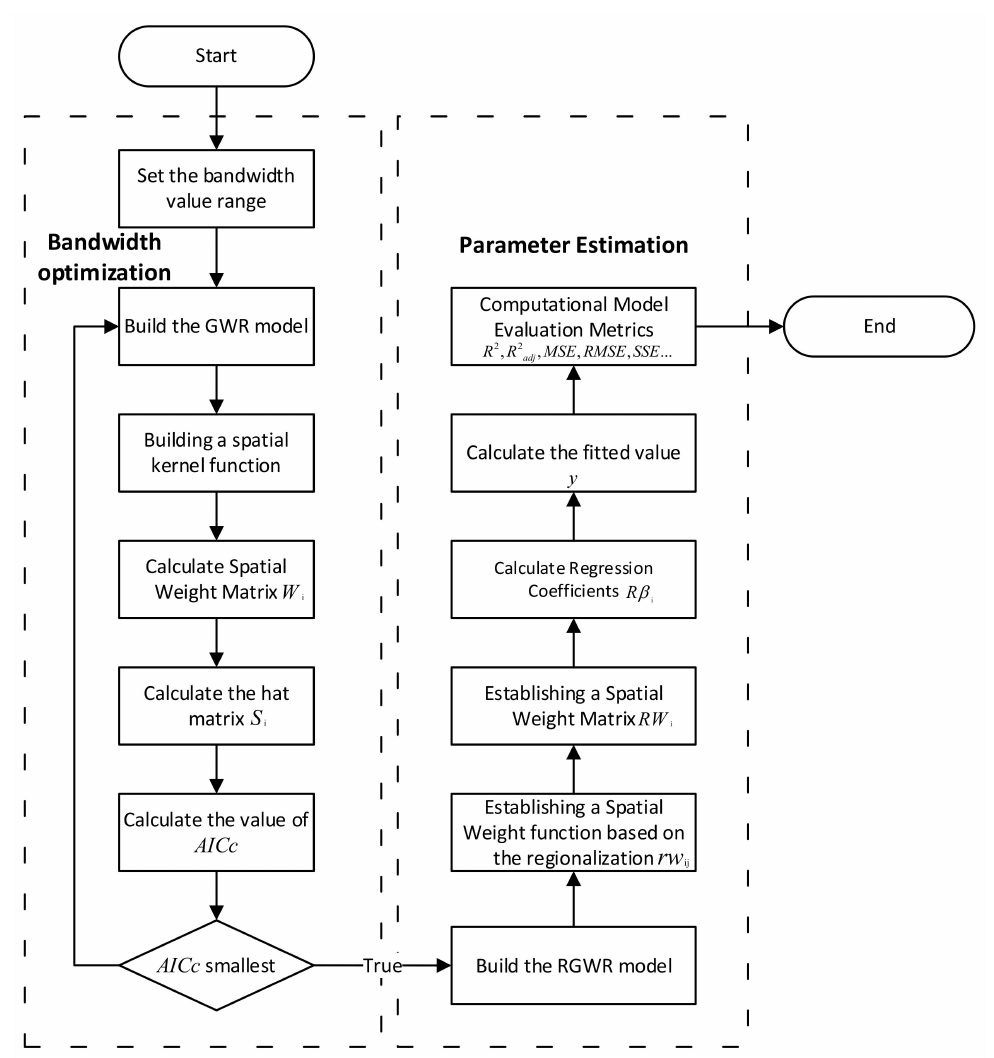
Figure 2. Algorithm process of